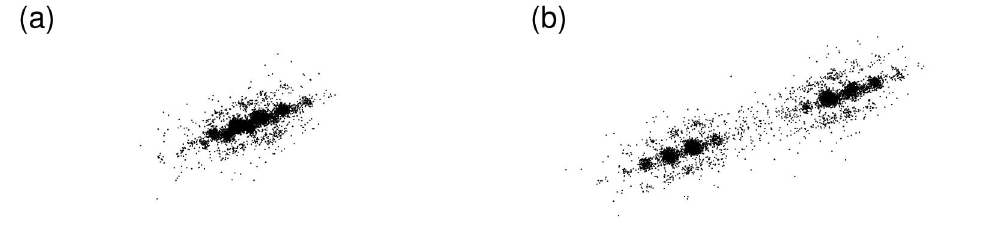
Figure 5. Displacement plot projected on the xy-plane of state J at T = 102 at times ( a ) t = 1.11 × 10 4 , and ( b ) t = 3.25 × 10 4 , for system size N = 5376.